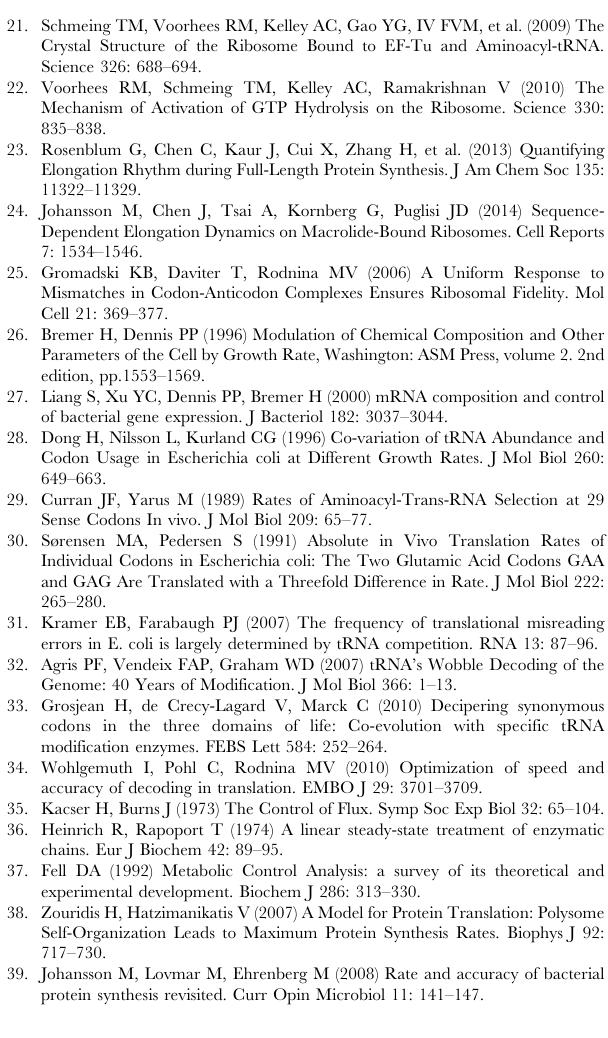
Figure S4 Incorporation of radioactively labeled amino acids for different dissociation rates. Experimental data (black stars) for the incorporation of radioactively labeled amino acids at a growth rate of 0.7 dbl/h [30] and simulation curves obtained for five different values of the initial dissociation rate v off . The orange simulation curve in the middle corresponds to ~ 1400 = s, see Table 2. This value has been obtained v off ~ v ? off from the minimization of the kinetic distance and provides an excellent fit to the data. The red, blue, green, and black curves have been obtained for simulations with v off ~ 2 v ? , 1 : 2 v ? , off off 0 : 8 v ? , and 0 : 5 v ? , respectively. Thus, changing the value of off off v off by 20% leads to a significant deviation of the simulation curve from the experimental